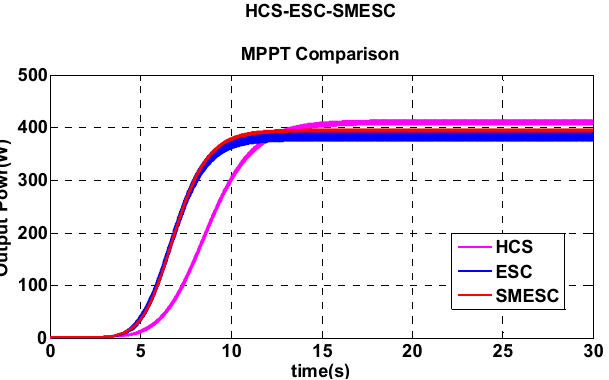
Figure 15. Output dynamic response of HCS, ESC and SMESC algorithms, respectively (constant wind speed).